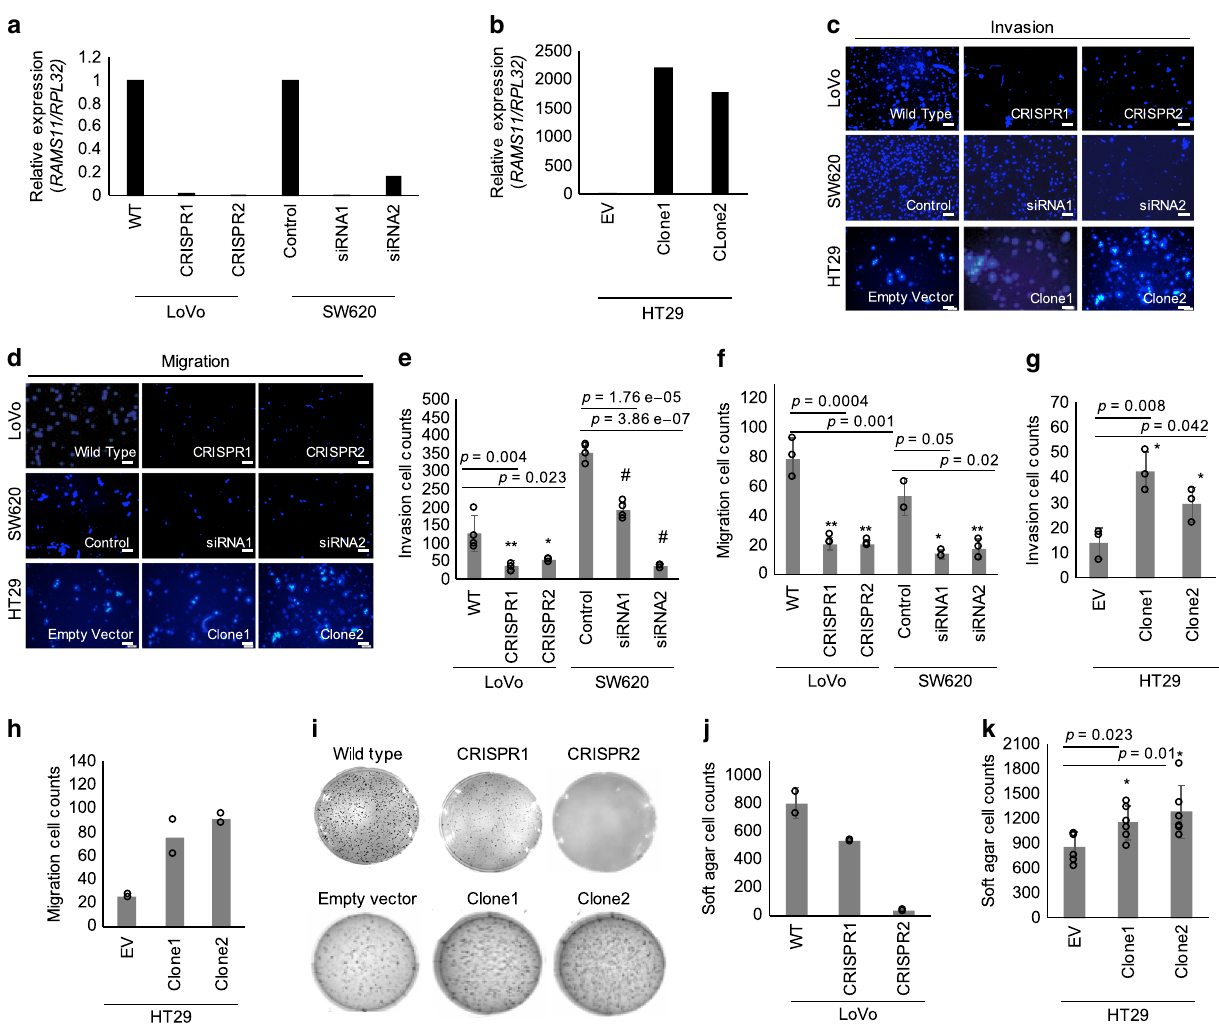
Fig. 2 RAMS11 promotes an invasive phenotype. Expression of RAMS11 in a LoVo CRISPR KO, SW620 silenced cells, and b HT29 overexpressing cells (Clone1 and Clone2) as measured by qPCR. c Images of DAPI-stained LoVo RAMS11 CRISPR KO cells and SW620 siRNA silenced cells show decreased invasion compared with controls. HT29 cell lines overexpressing RAMS11 show increased invasion. d Images of LoVo RAMS11 CRISPR KO cell lines and SW620 cells transfected with RAMS11 siRNAs show decreased migration. HT29 cell lines overexpressing RAMS11 show increased migration. e , f Quanti fi cation of invaded ( n = 4) and migrated cells ( n = 3) in LoVo and SW620 cells. g , h Quanti fi cation of invaded ( n = 3) and migrated cells ( n = 2) in HT29 cells. i RAMS11 CRISPR KO cells decreased growth on soft agar ( n = 2) and RAMS11 overexpressing cells ( n = 6) increased growth on soft agar. j , k Quanti fi cation of soft agar cells. All data are presented as mean values±s.d, analyzed by two-tailed paired t- test, and repeated more than two times. Bar = 25 μ M, * p <0.05, ** p <0.005, # p <0.0005. Source data are provided as a Source Data